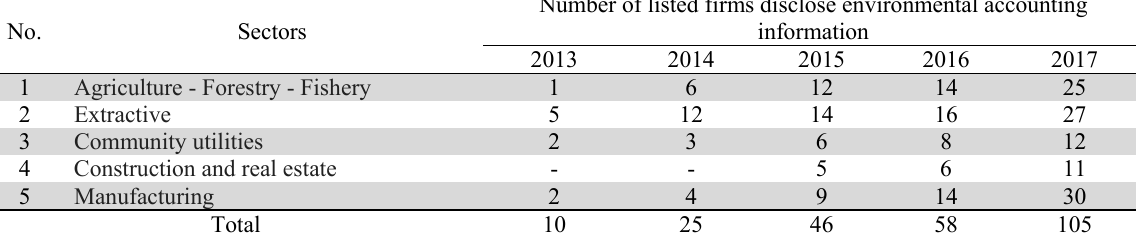
Research Sample Statistics